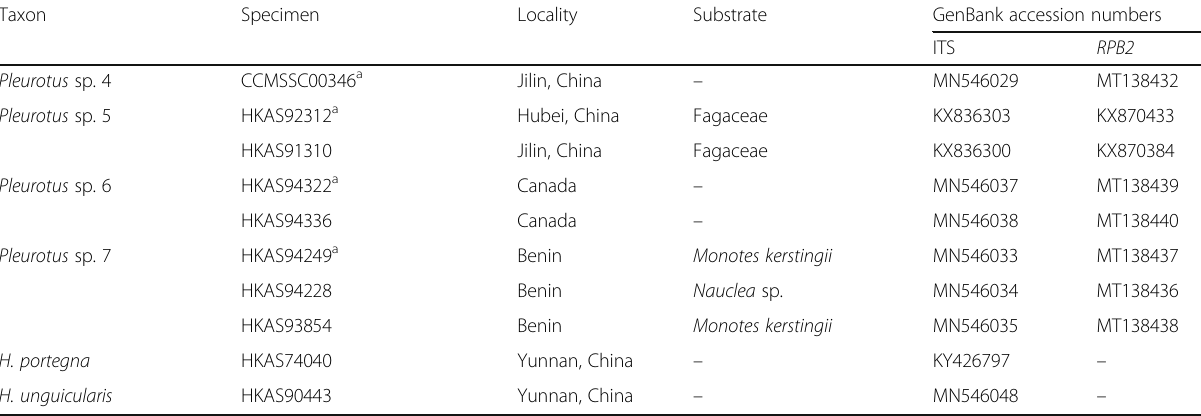
Table 1 List of specimens used to infer the phylogeny of Pleurotus ostreatus species complex